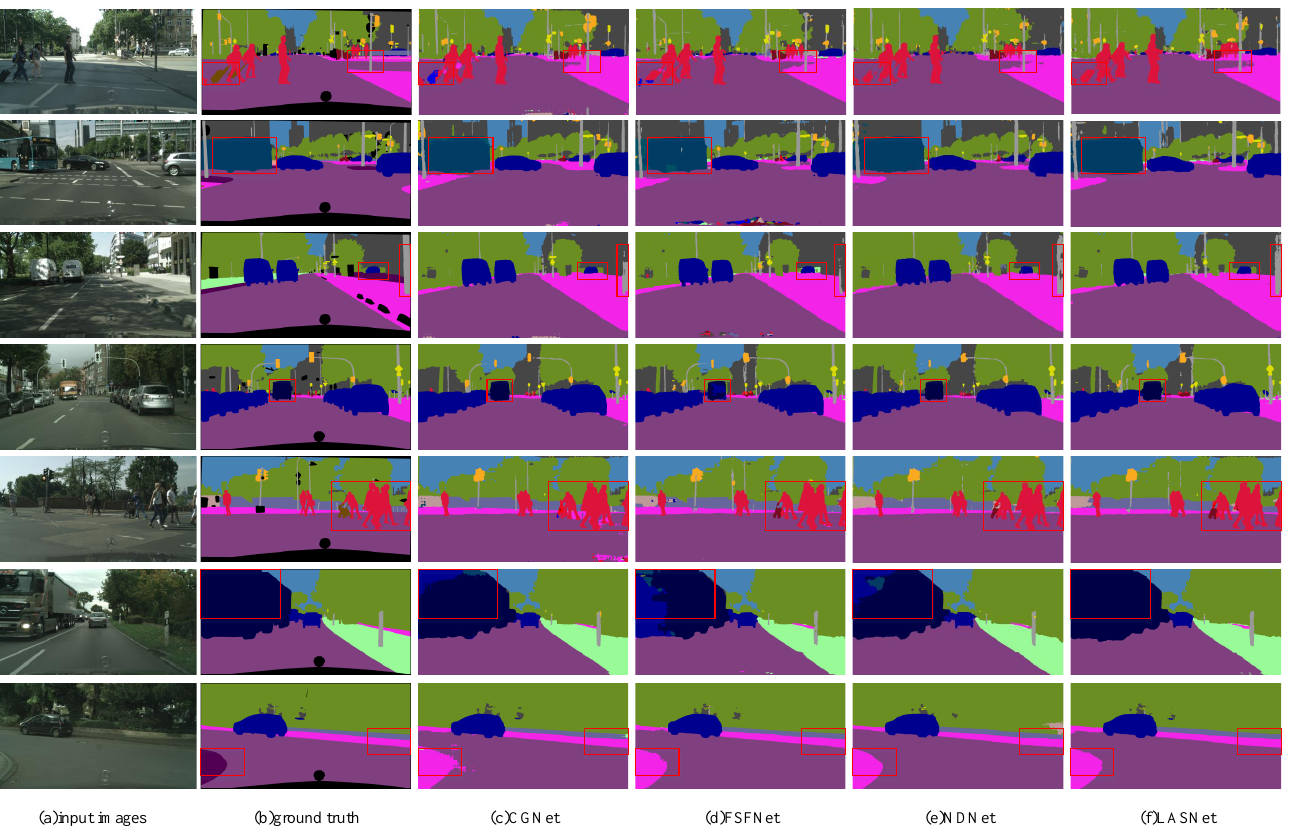
Figure 6. Visual Detail results on CityScapes validation dataset. From left to right are input images, ground truth, segmentation outputs from CGNet, FSFNet, NDNet, and our LASNet.